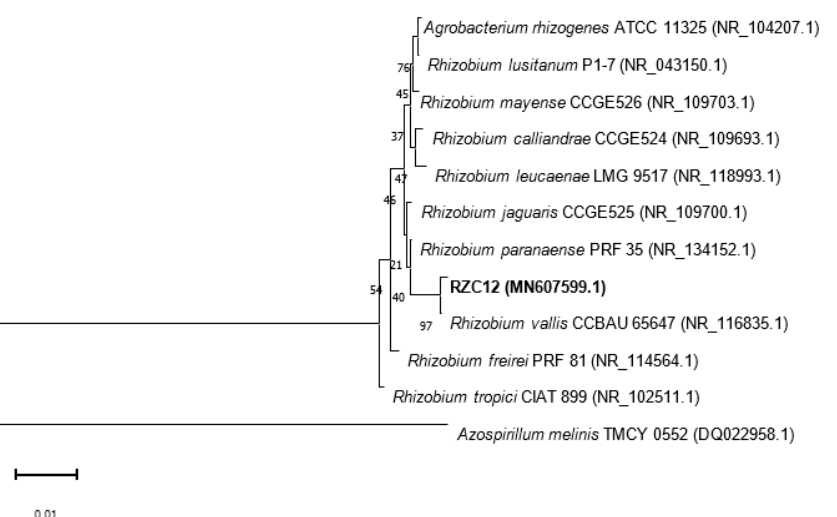
Figure 5. Phylogenetic tree of sequences of the 16S rRNA gene (1354 positions) of Rhizobium sp.